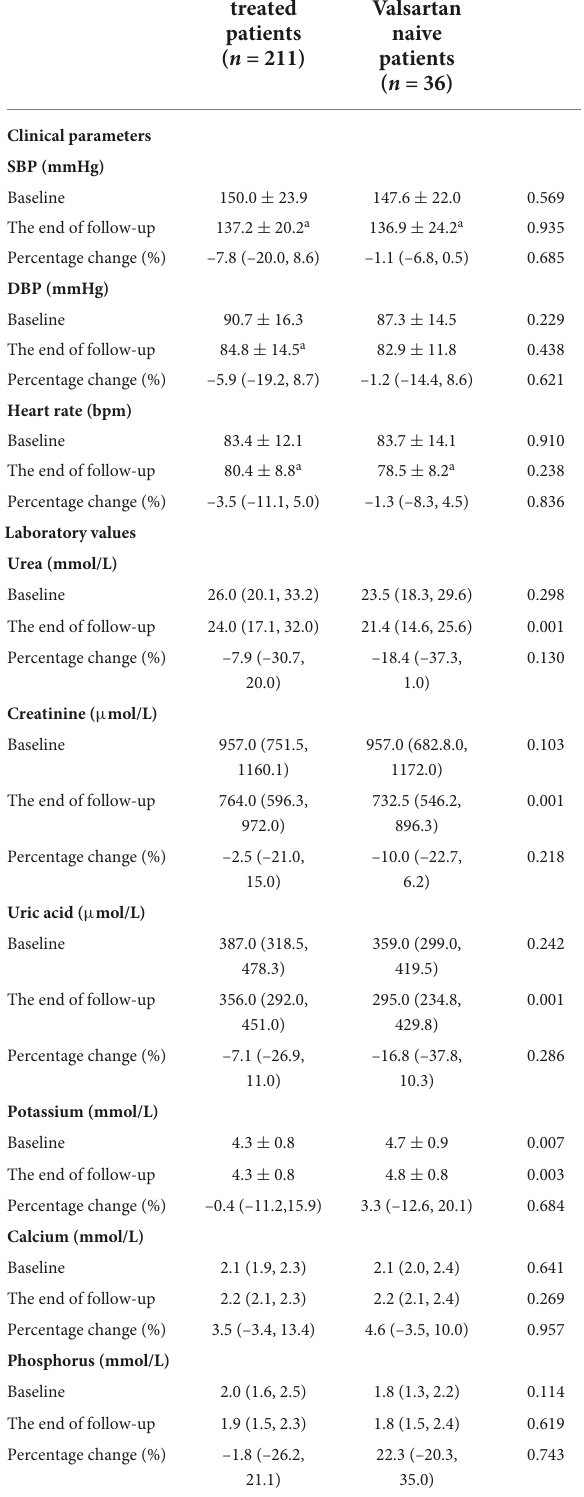
TABLE 3 Clinical data at baseline and the end of follow-up of 211 HFpEF patients who were already treated with ACEi/ARB and 36 HFpEF patients who were sacubitril/valsartan